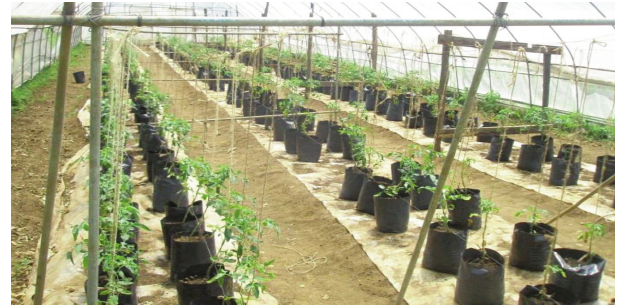
Fig. 2 ­ Transplants on treatment pots in the